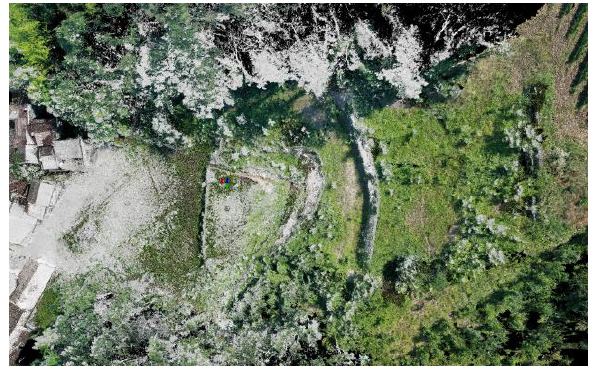
Figure 2. Top view of the point cloud of the first case study, the landslide slop. This point clouds has been created by the different survey